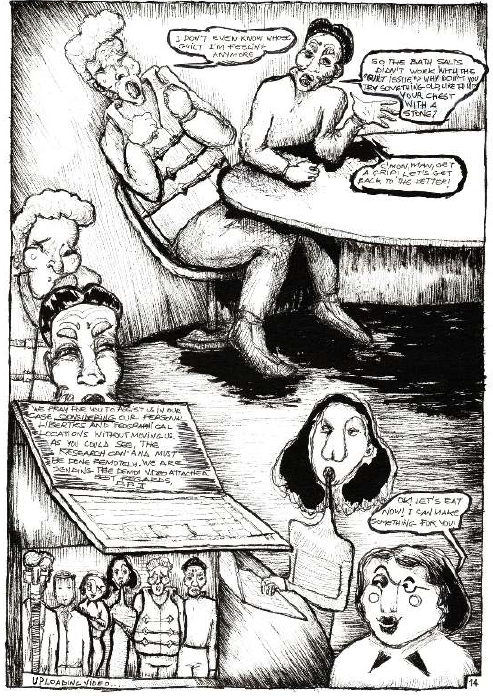
Figure 15: Plate 14, Diamond Princess II